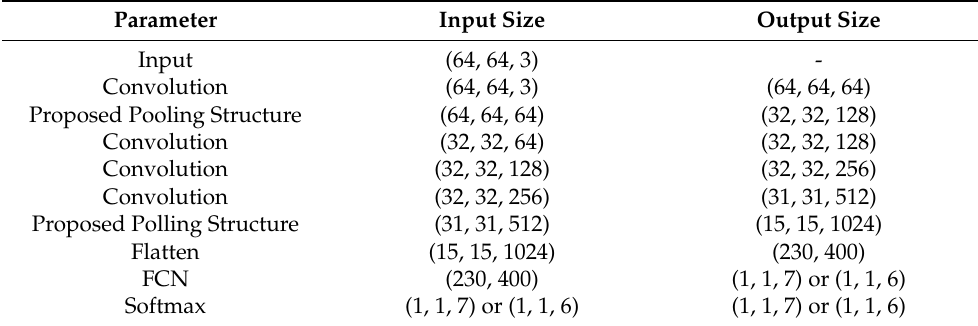
Table 1. Detail structure of proposed restructured CNN.